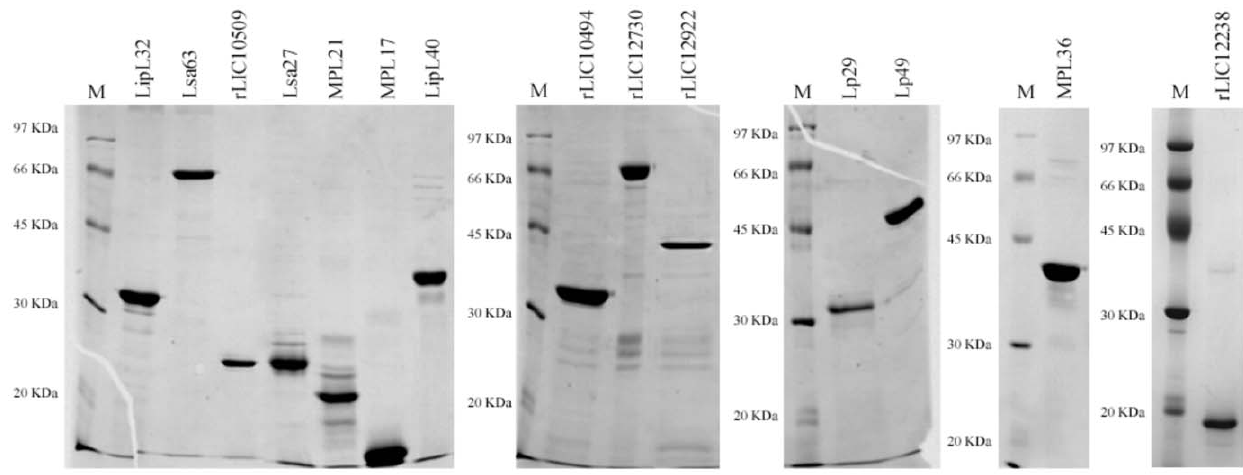
Figure 1. SDS-PAGE analysis of purified recombinant proteins. Recombinant proteins were expressed in E. coli BL21 (DE3) or SI and purified from the bacterial cell lysate using Ni 2 + -charged chelating Sepharose columns. M: molecular mass protein